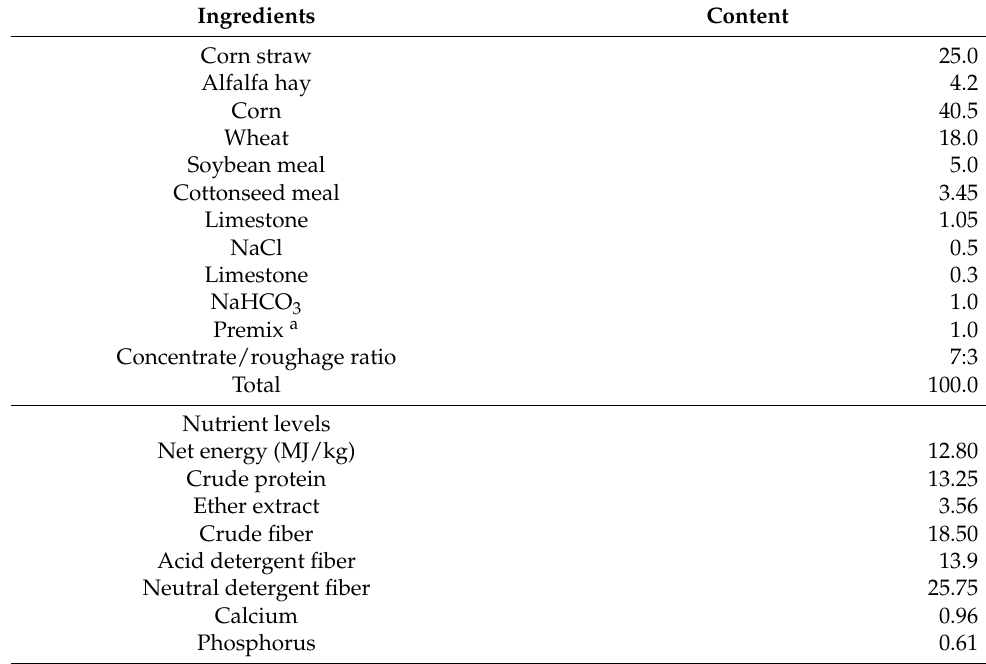
Table 1. Nutrient level and composition of experimental diet (% DM